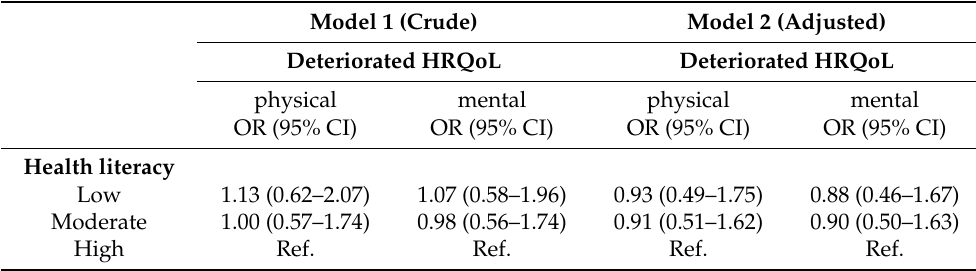
Table 3. Association of health literacy (HL) with deteriorated health-related quality of life (HRQoL), crude (model 1) and adjusted for Charlson comorbidity index, vascular access, dialysis effectiveness, age and gender (model 2): results of logistic regression analysis leading to odds ratios (OR) and 95% confidence intervals (CI), n = 413, patients from 20 dialysis clinics in